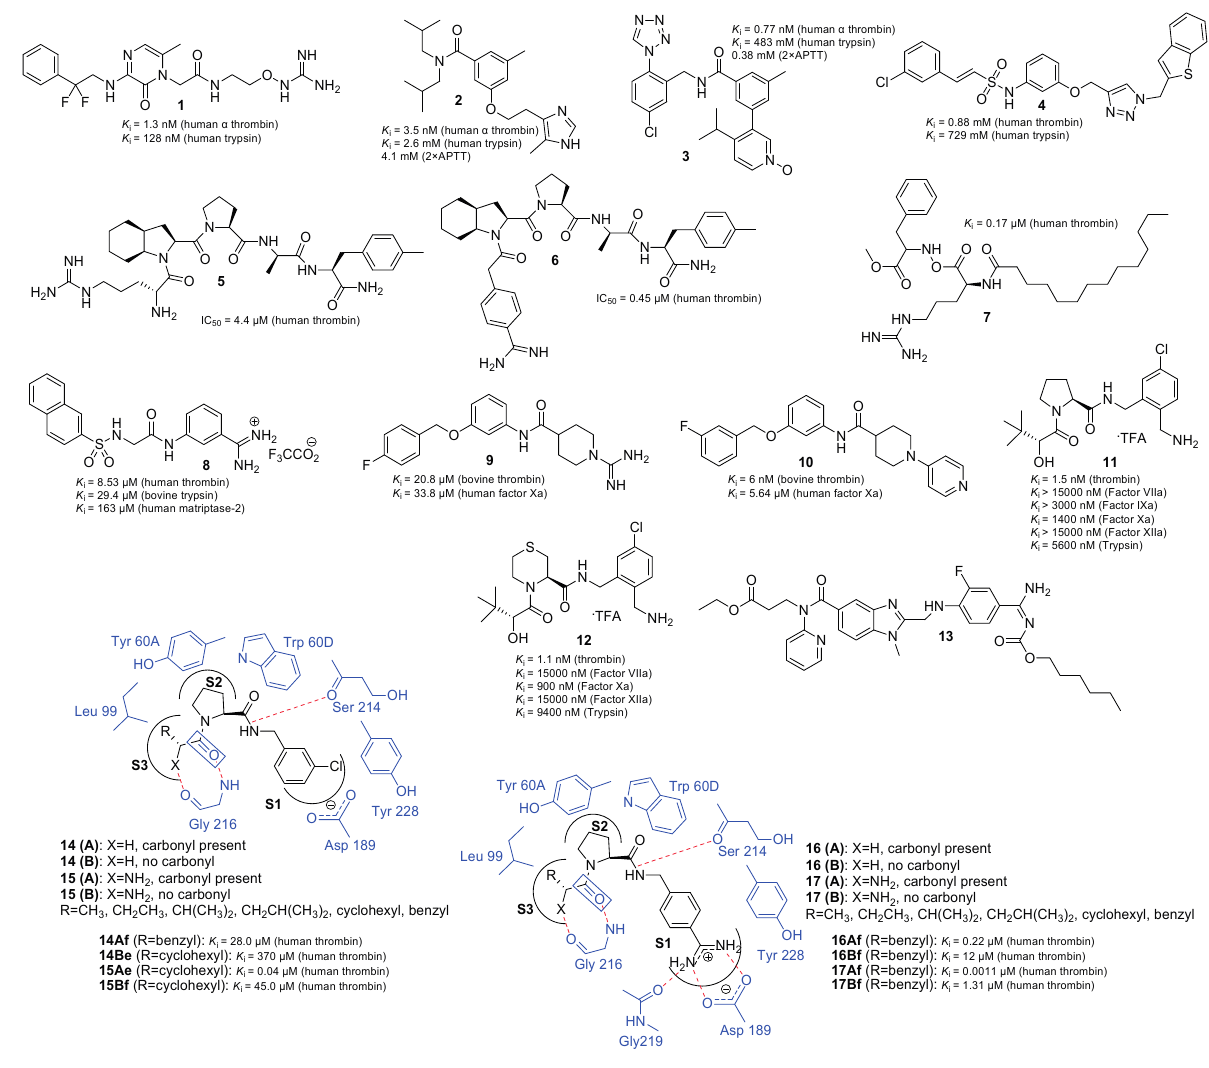
Figure 3. The chemical structures of selective thrombin